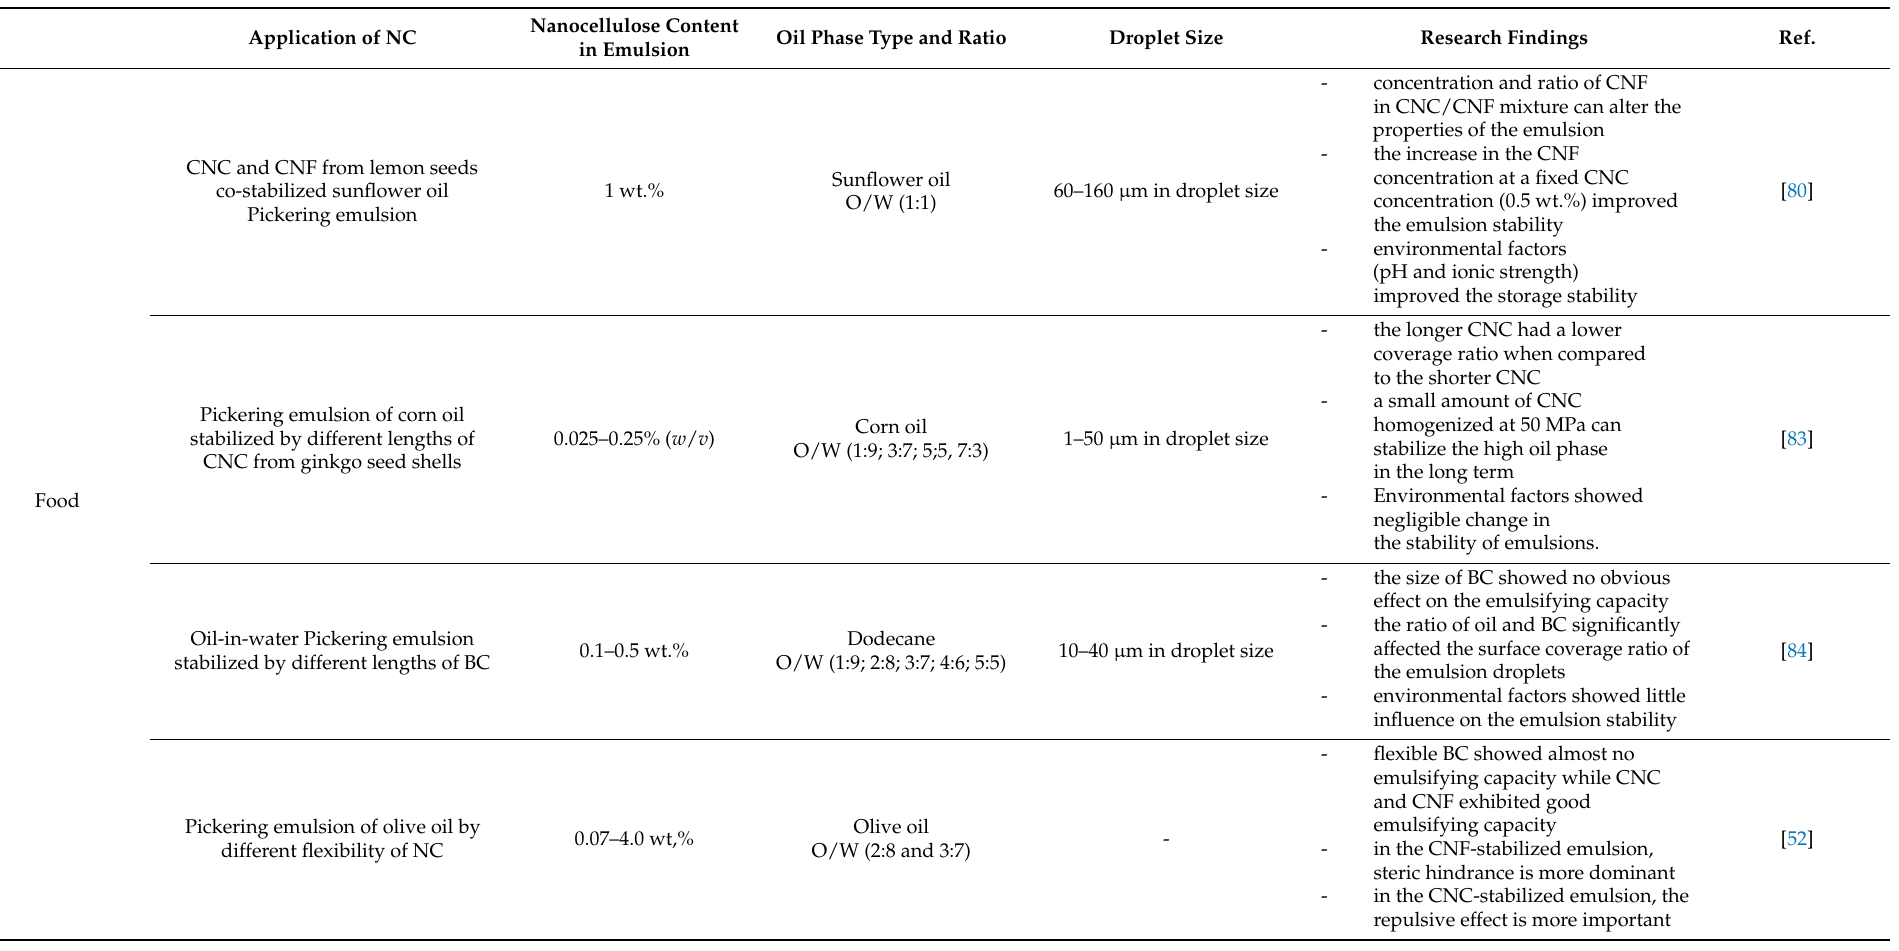
Table 3. Summary of some recent research articles on the use of nanocellulose as a Pickering emulsifier in food, cosmetic, and biomedical